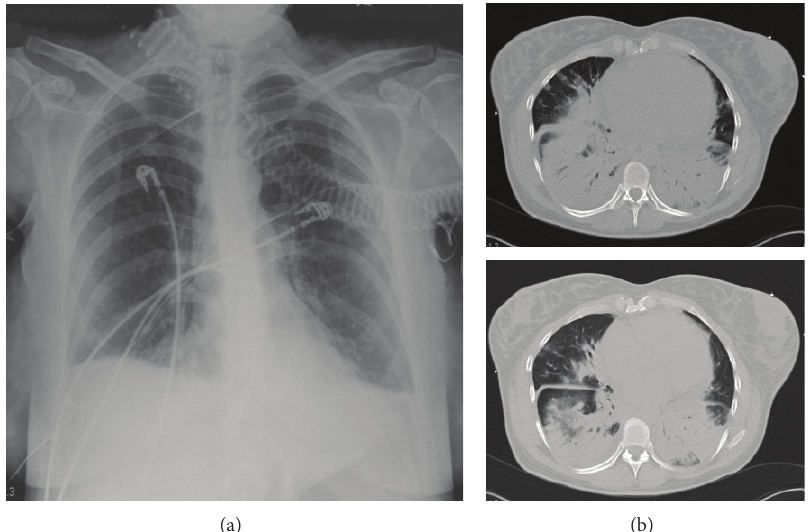
Figure 2: Posteroanterior lung radiograph of the mother described in Case 1 on the day of delivery (a) and computed tomography of the thorax on the day after delivery (b).